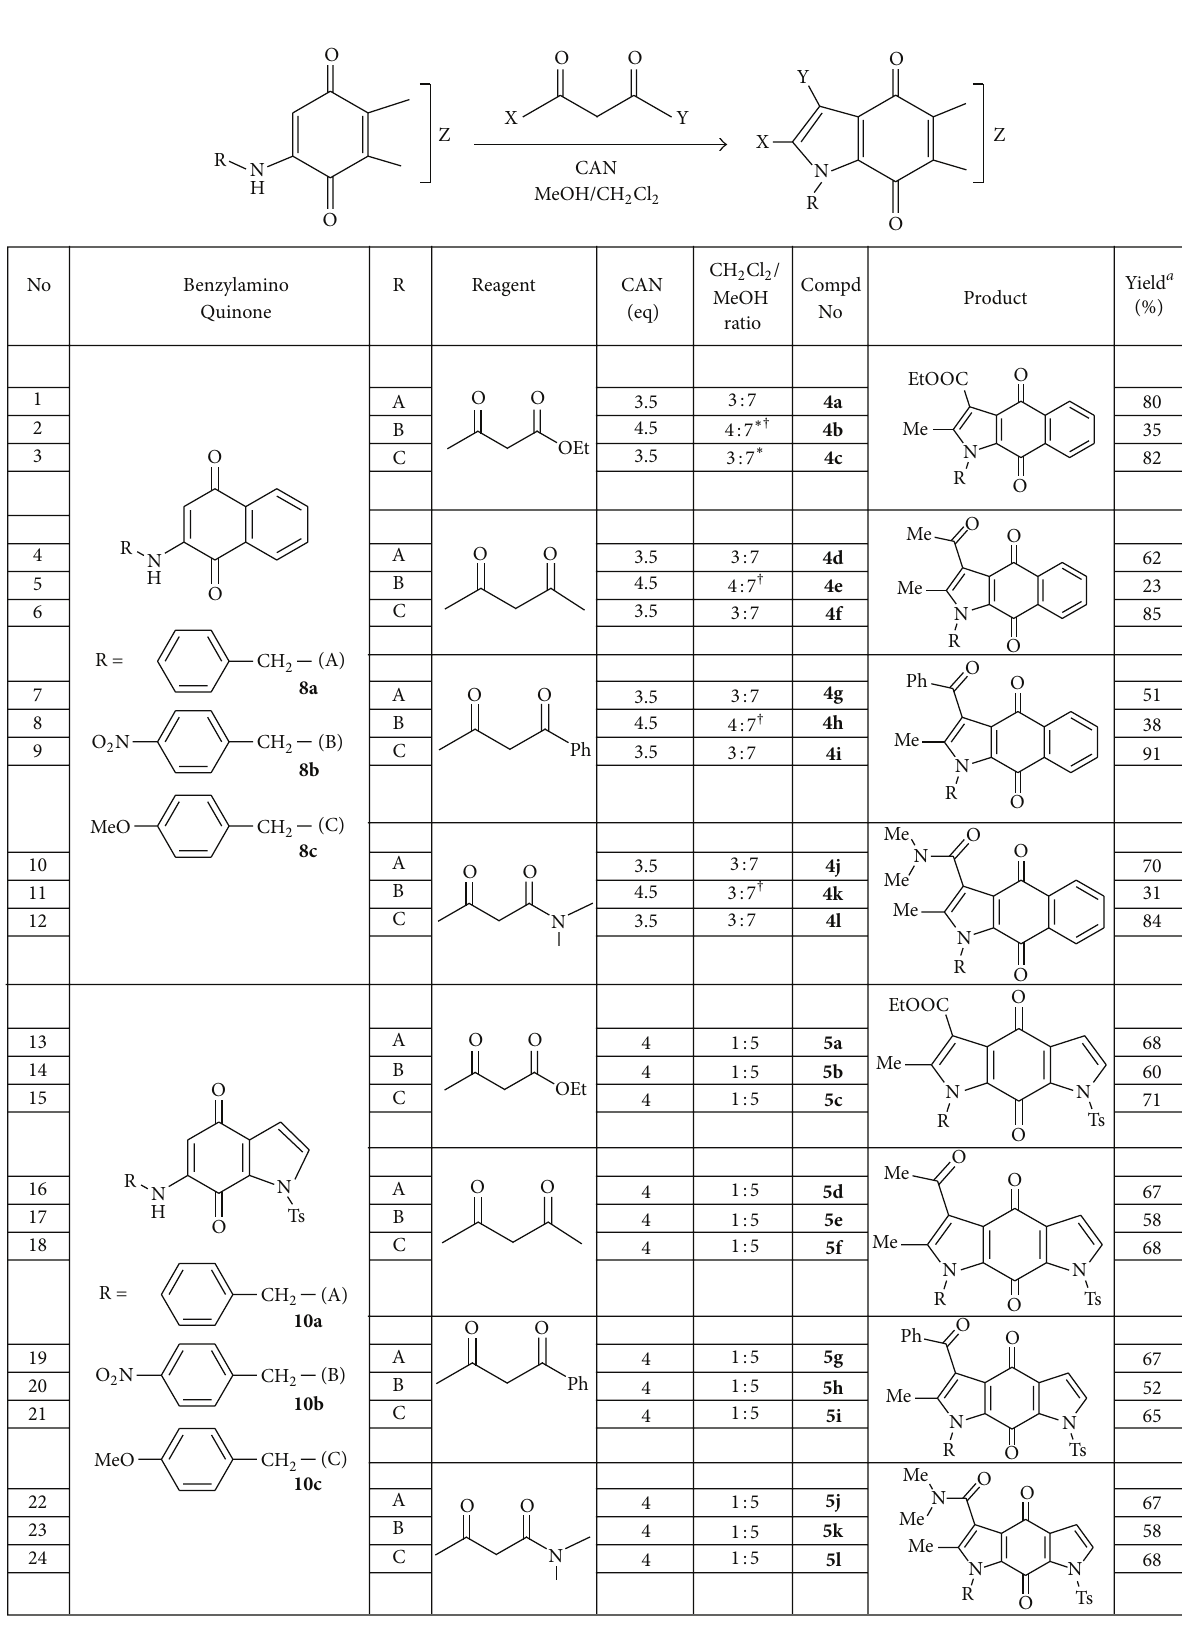
† triple volume of solvents and